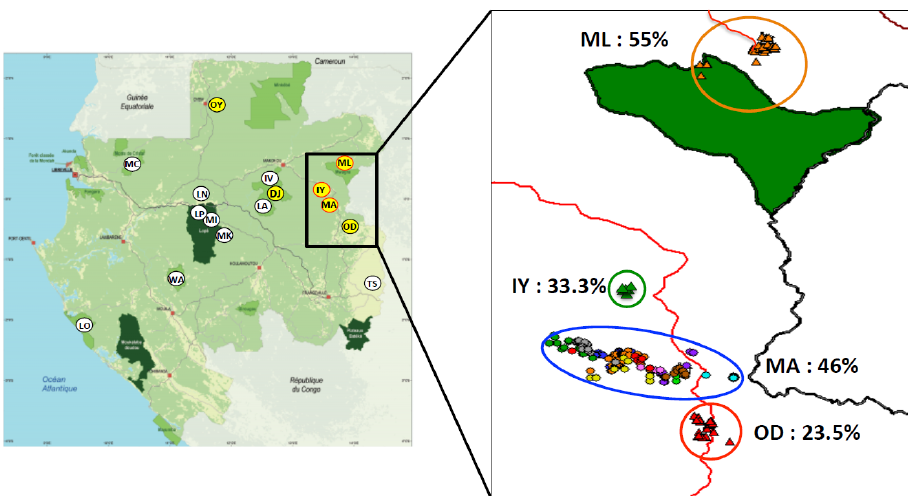
Figure 3. SIVcpz antibody positive samples from north-east Gabon. A/ Yellow circles with red perimeter represent sampling sites where SIVcpz have been PCR amplified. B/ details of SIVcpz positive sampling sites: colored circles correspond to the color codes used to represent the different SIVcpz identified in Figures 3 and 4: Blue = MA, Green = IY and Orange = ML. Triangles correspond to SIVcpz antibody positive faecal samples collected in OD, IY and ML. Dots correspond to SIVcpz antibody positive faecal samples collected in MA. Prevalence based on serological tests is showed for each site. The trail linking Odjala to Malouma is represented by a red line. The green area corresponds to the different national parks. The site of DJ is not represented.